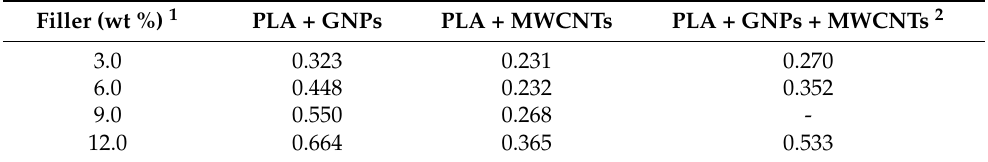
Table 1. Thermal conductivity of polylactic acid composites with varying filler contents (W/mK) [10]. Filler (wt %) 1 PLA +